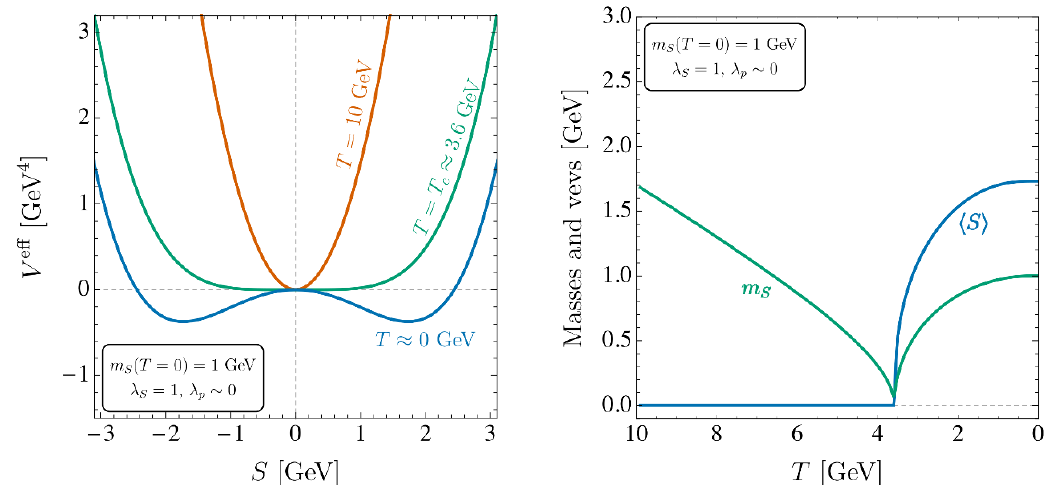
Figure 1 . Left: the e(cid:11)ective potential as a function of the S (cid:12)eld value at a high temperature (10 GeV), at the critical temperature T = T c (cid:25) 3 : 6 GeV and at T (cid:25) 0 GeV. We subtract a constant term at each T so that V e(cid:11) (0) = 0. Right: the scalar mass and vev as a function of